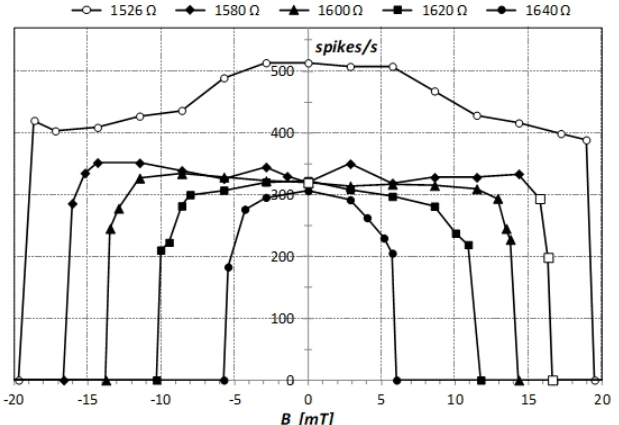
Figure 4. Experimental dependence of the spike count rate obtained in 10 s time window on the intensity of the static magnetic field for different R values given in the plot. Examples of V 1 ( t ) for points denoted by empty squares are shown in Figure 2.